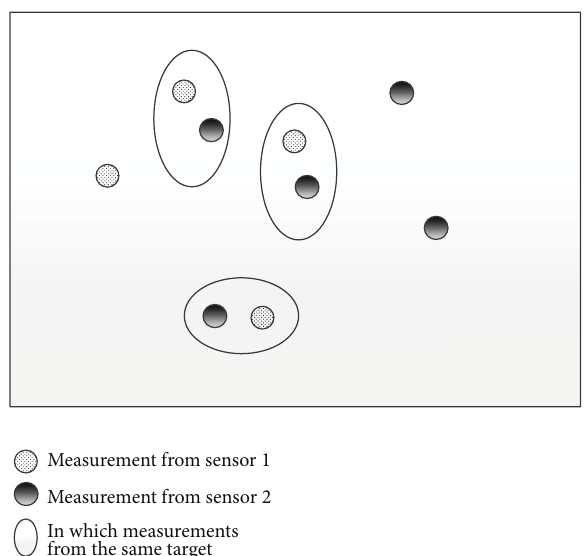
Figure 2: Distribution of measurements from different sensors.